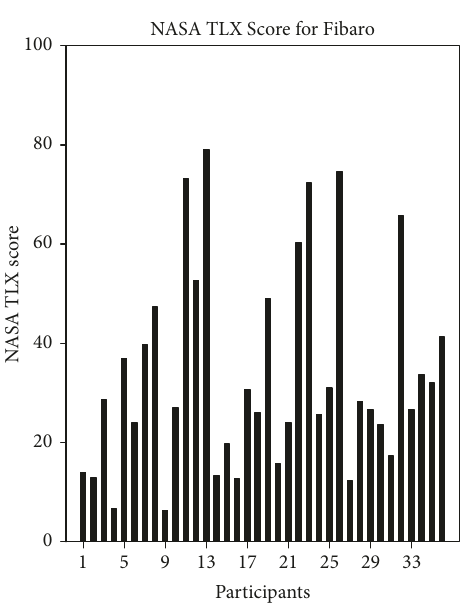
Figure 8: Fibaro NASA TLX